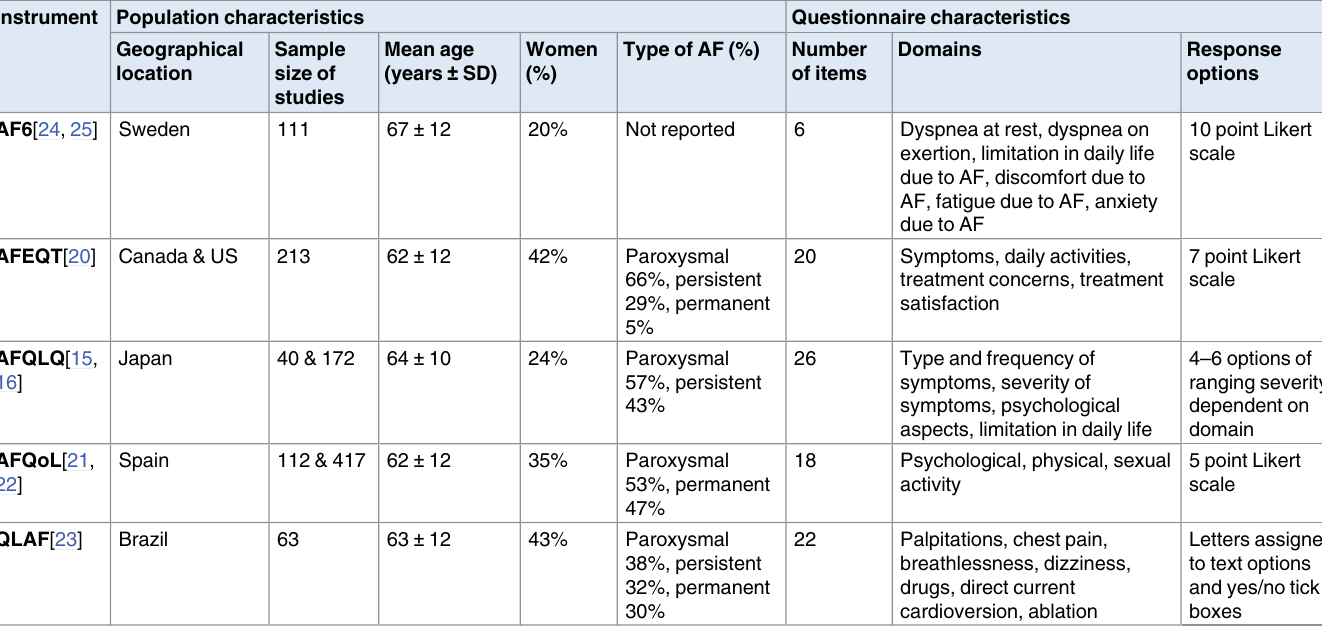
Table 2. Characteristics of included